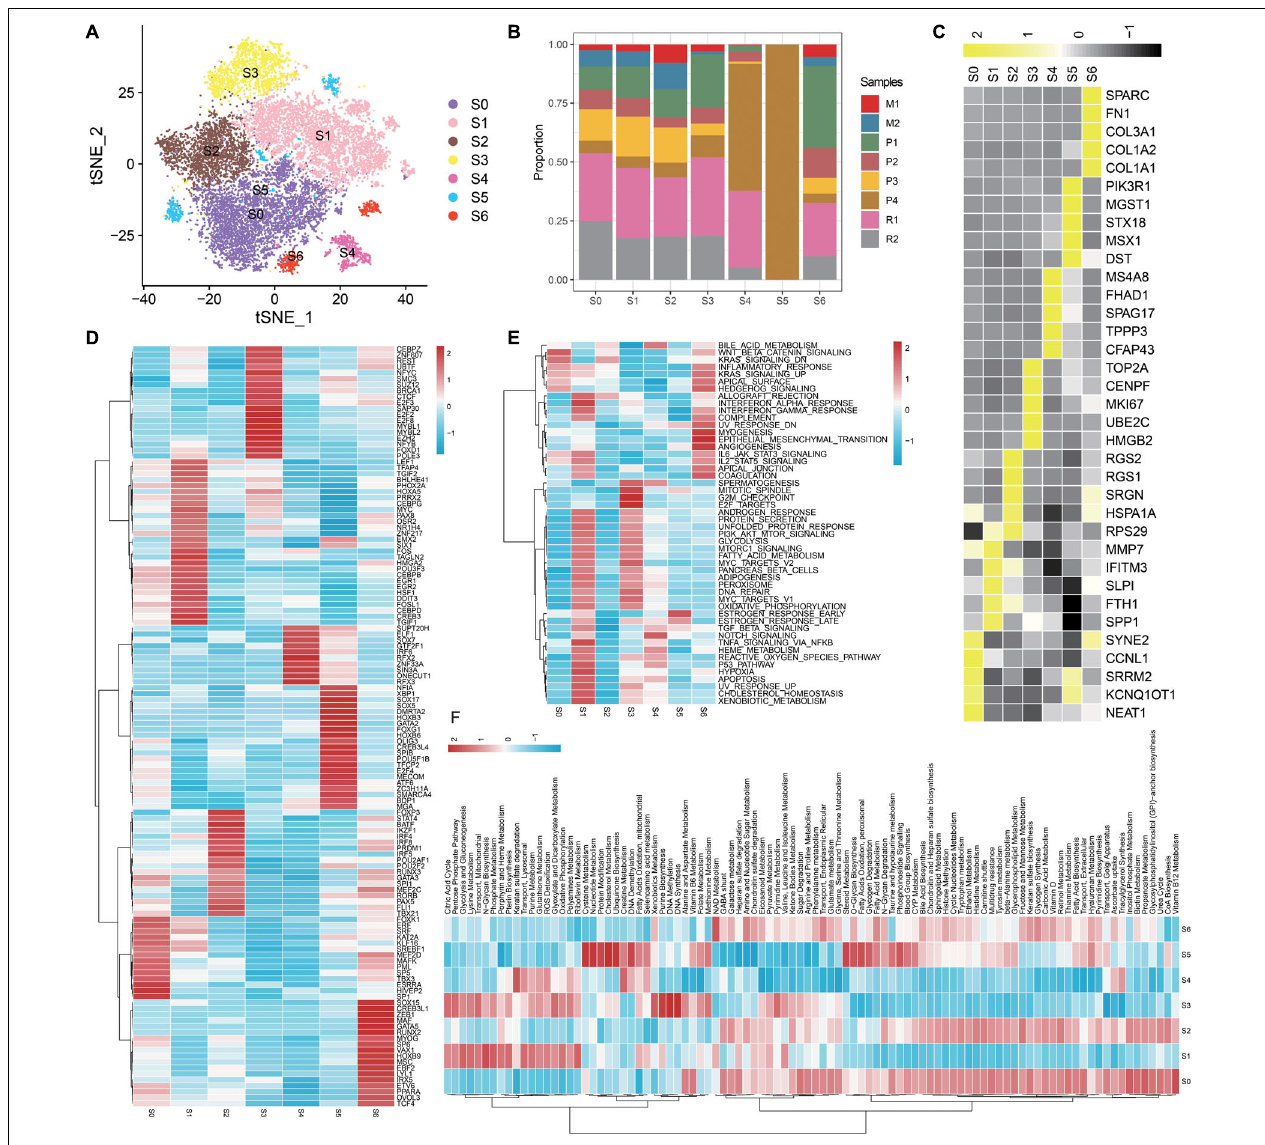
FIGURE 2 | Detailed characterization of malignant epithelial cells. (A) tSNE plot showing seven subgroups generated from malignant epithelial cells. (B) Heatmap showing the average expression of the top five markers across different subgroups. (C) The proportion of diverse subgroups across different sample origins. Differences in the activities of the TFs (D) , HALLMARK pathway (E) , and metabolic pathways (F) in each malignant epithelial